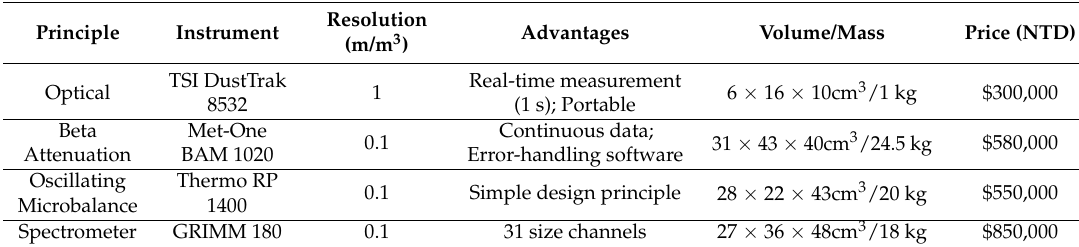
Table 1. Comparison of aerosol monitoring